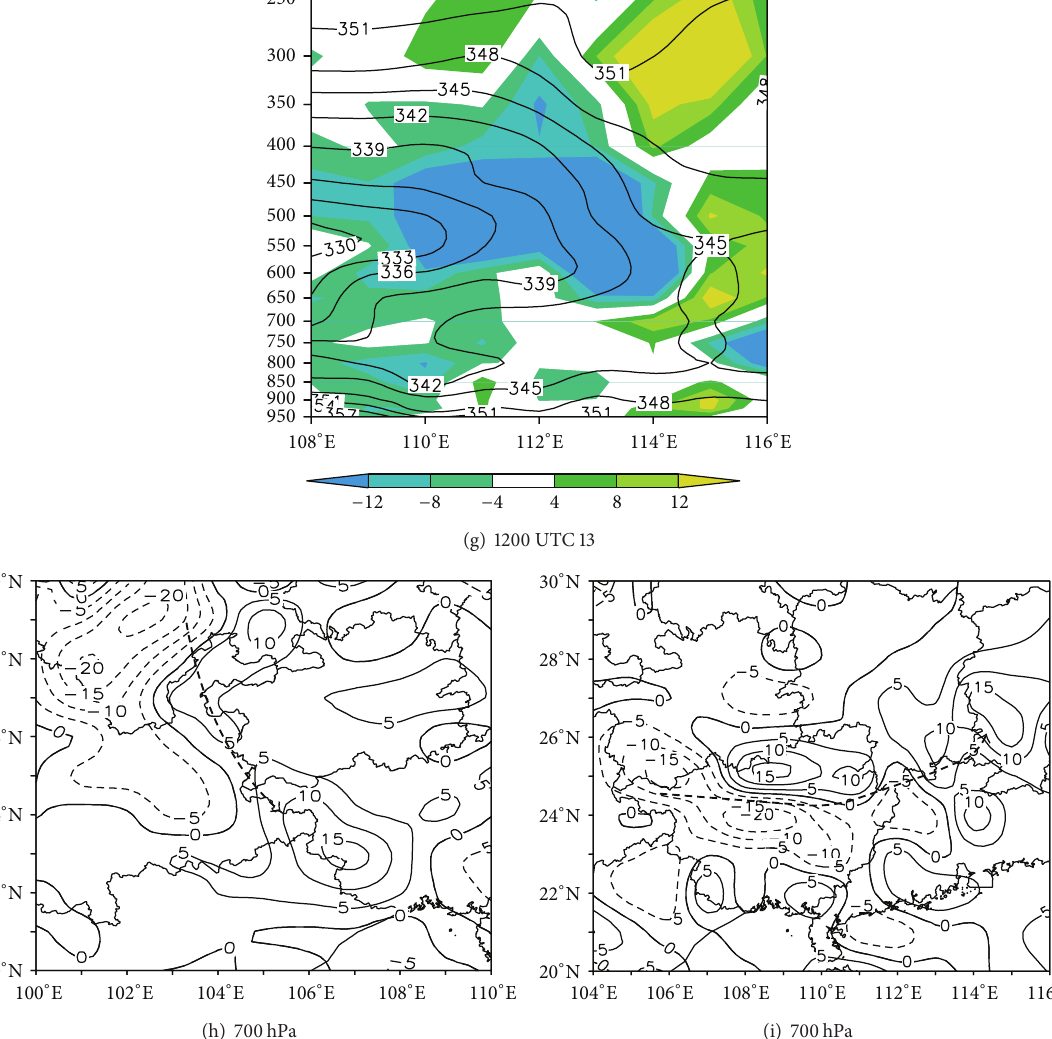
⃗𝑉⋅∇𝜃 (K) and the advection − (colored shaded in 10 −5 K ⋅ s −1 ) at the se se ⃗𝑉 ⋅ ∇𝜃 over 18 UTC June 11 to 00 UTC June 13, se